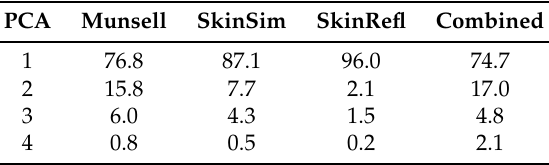
Table 3. Resulting PCAs for all sets. Variance of each of the sets along the first 4 principle components. PCA